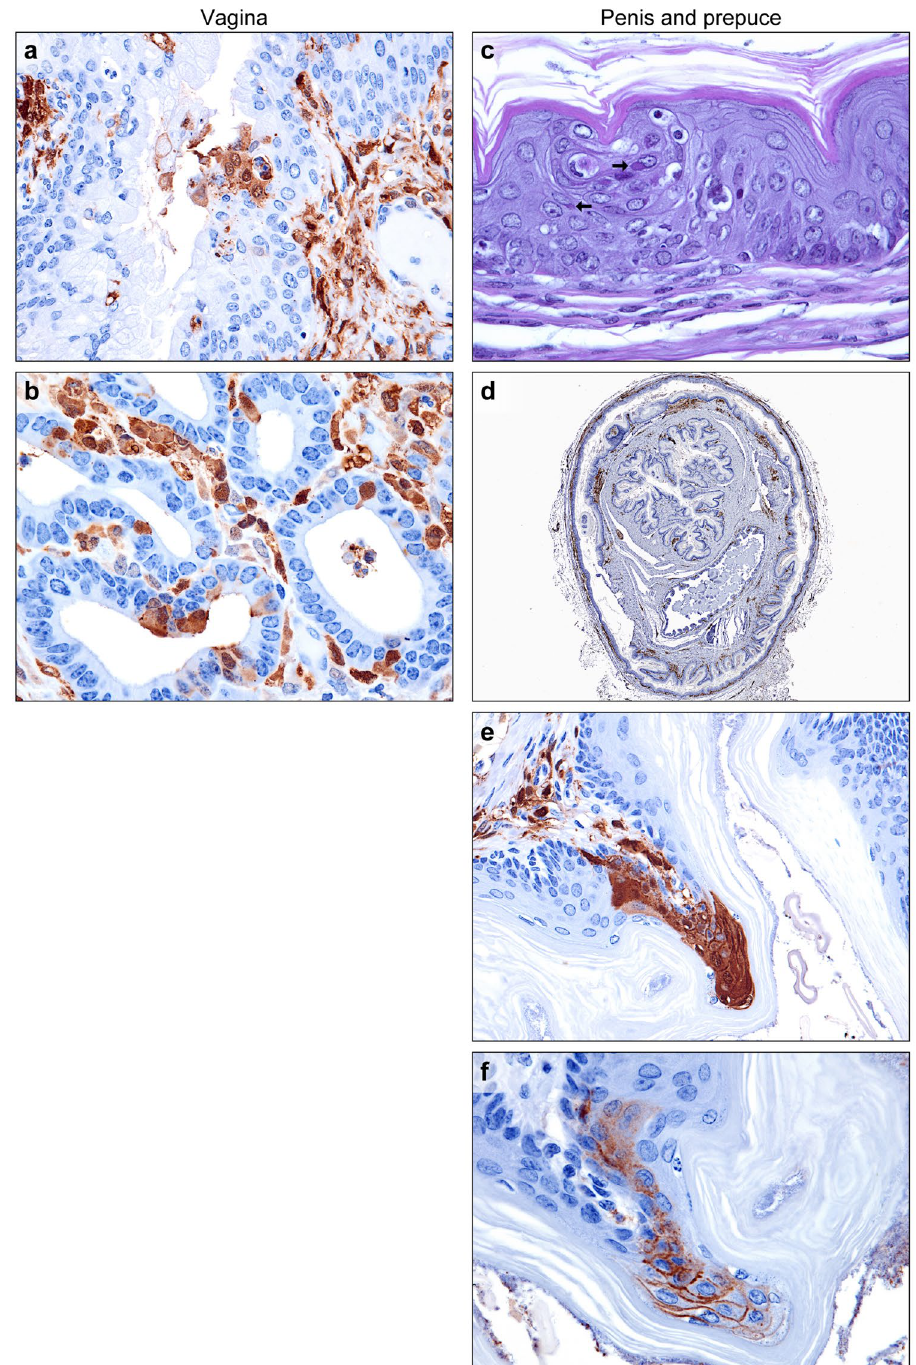
Figure 4. EBOV infection of the vagina, penis, and prepuce. ( a ) Rare small clusters of infected metestrus epithelial cells in the vagina (EBOV VP40 IHC: DAB chromogen and hematoxylin). ( b ) Endometrial gland epithelial cells, as well as stromal cells and macrophages, of the uterine body (EBOV VP40 IHC: DAB chromogen and hematoxylin). ( c – f ) Penis and prepuce. ( c ) Scattered small clusters of keratinocytes within the stratified squamous cornifying epithelium with large viral intracytoplasmic inclusions (arrows). ( d ) In addition to stromal fibroblasts and macrophages, clusters of epithelial cells covering the penis and prepuce (EBOV VP40 IHC: DAB chromogen and hematoxylin). ( e ) Higher magnification of subfigure. ( d , f ) Clusters of infected epithelial cells. (EBOV GP IHC: DAB chromogen and